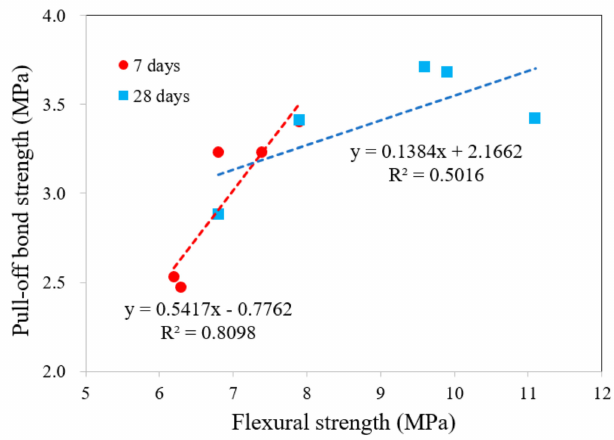
Figure 8. Relationships between averaged flexural and pull-o ff bond strengths at seven and 28